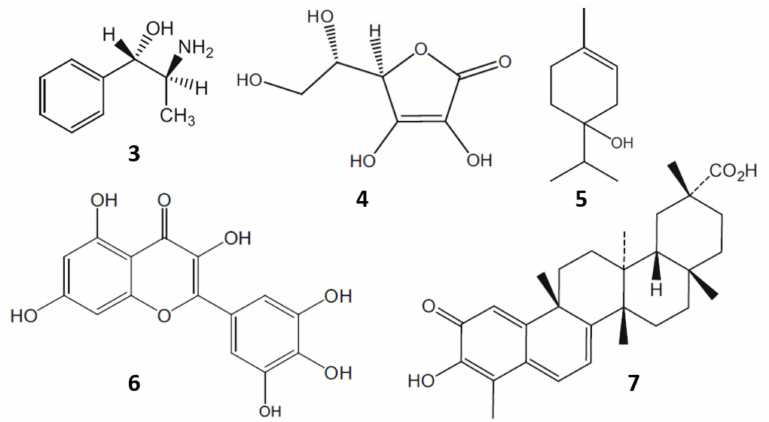
Figure 3. Some bioactive components of khat: cathine ( 3 ); ascorbic acid ( 4 ); α -terpineol ( 5 ); myricetin ( 6 ); and celastrol ( 7